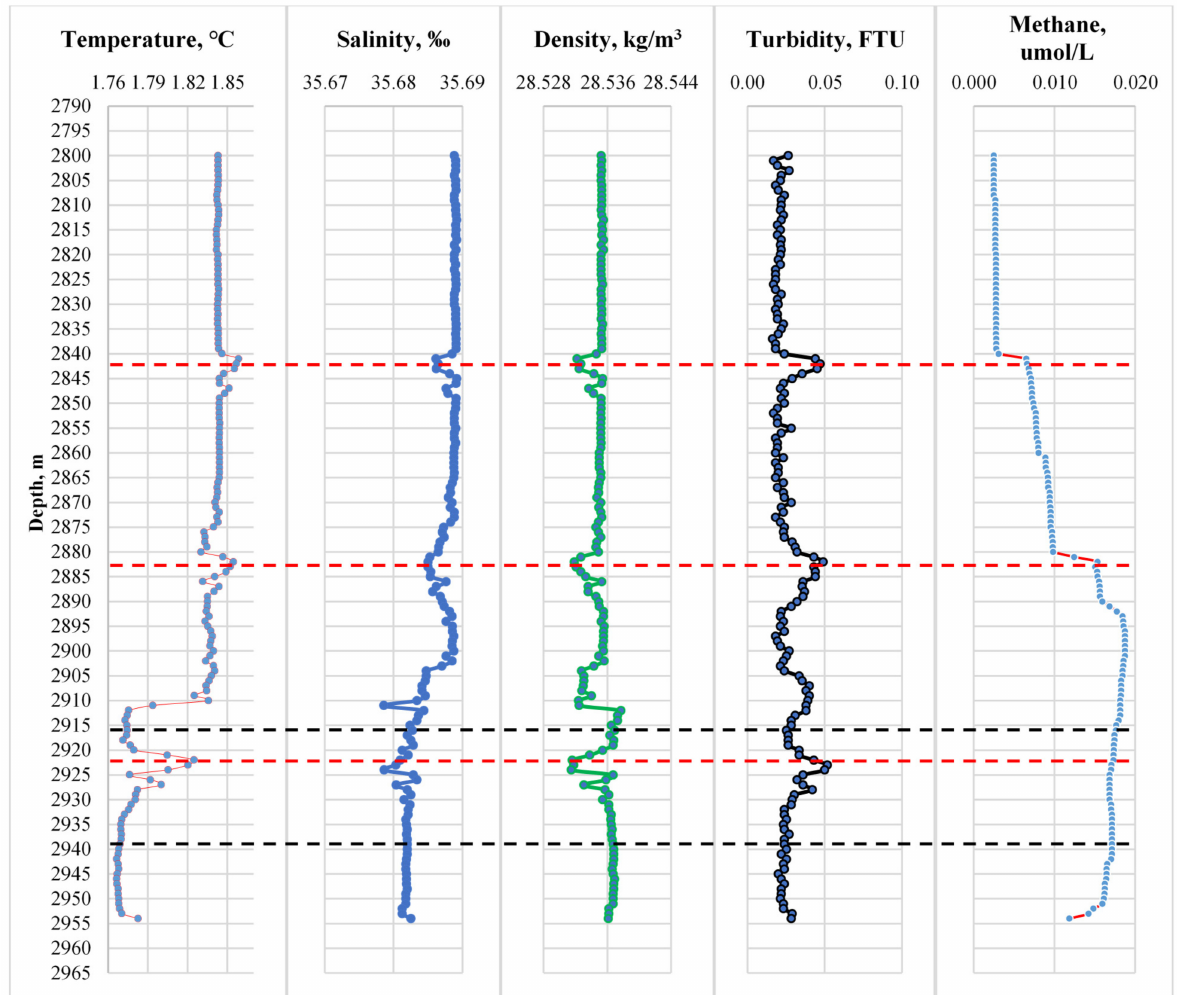
Figure 4. Horizons with anomalous CTD parameters in the ascending plume of the hydrothermal plume near the Irina 1 crater, Logachev field. Red dotted line: scattering horizons; black dotted line: layers of relatively cold waters.